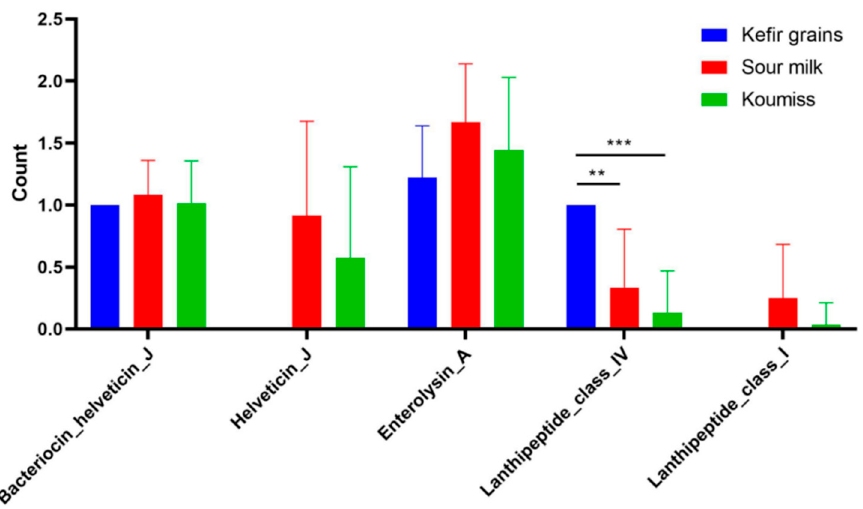
Figure 8. Difference analysis of bacteriocins produced by L. kefiranofaciens strains isolated from Figure 8. Di ff erence analysis of bacteriocins produced by L. ke fi ranofaciens strains isolated from different sources. **: Samples have a large significant difference. ***: Samples have a very large di ff erent sources. **: Samples have a large signi fi cant di ff erence. ***: Samples have a very large significant signi fi cant di ff erence.